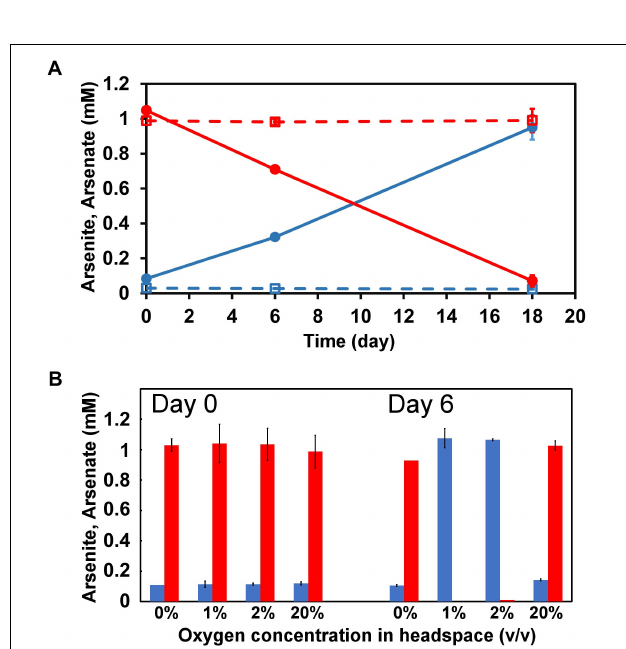
FIGURE 2 | Arsenite oxidation to arsenate by strain M52. (A) Changes in concentrations of arsenite (red) and arsenate (blue) in medium containing nitrate, incubated under anoxic conditions. Error bars represent standard deviation from two independent assays. Dashed lines represent uninoculated control. (B) Effect of oxygen concentration in headspace on arsenite oxidation in medium without nitrate. Red and blues bars represent concentrations of arsenite and arsenate, respectively. Error bars represent standard deviation from triplicates (20%) or duplicates (the